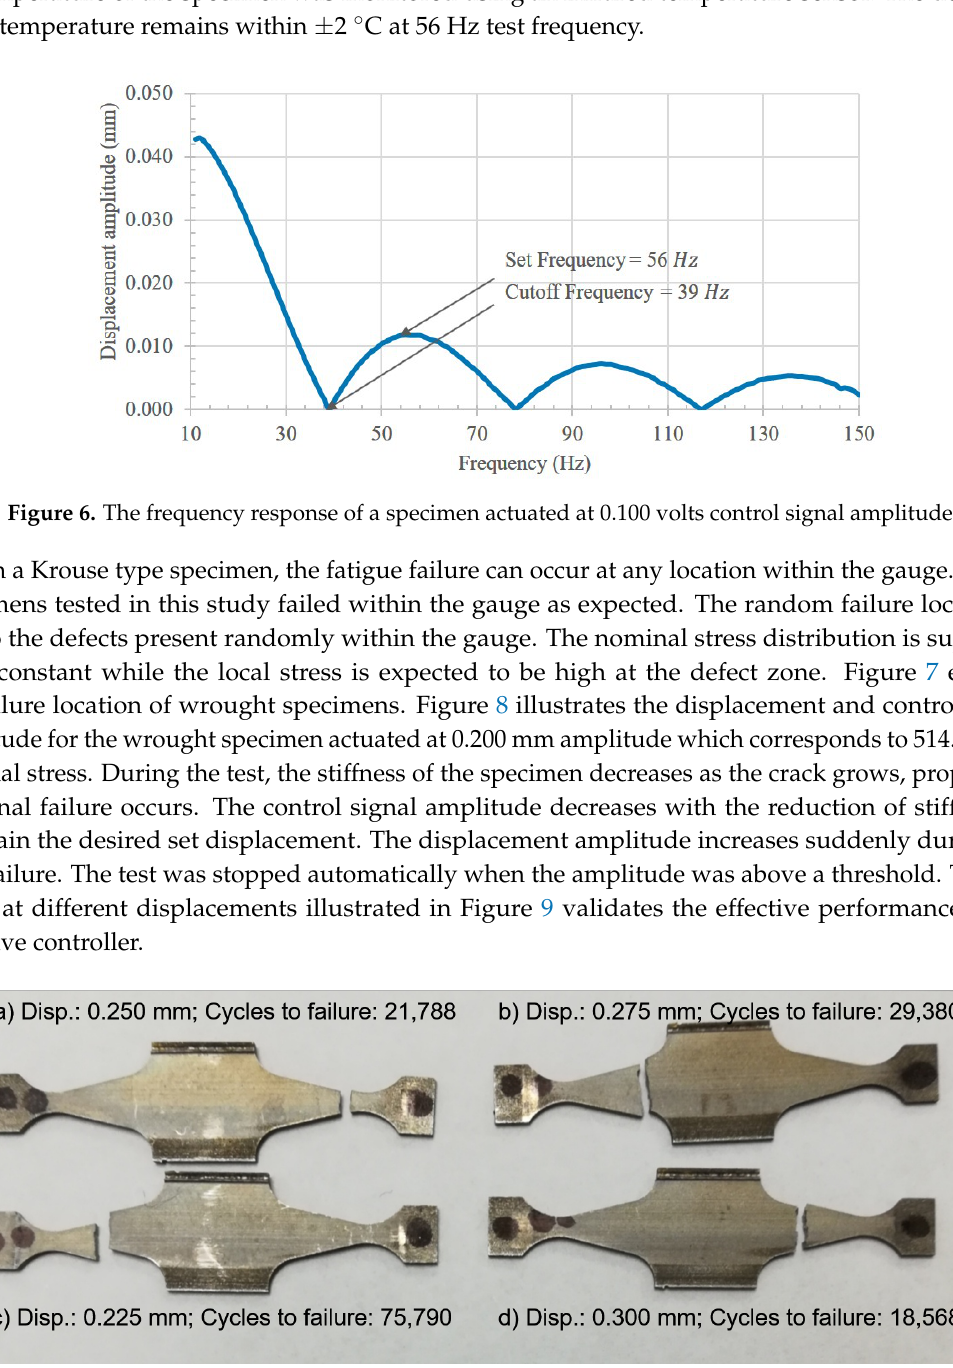
Figure 7. Fatigue failure of specimens actuated at different displacement